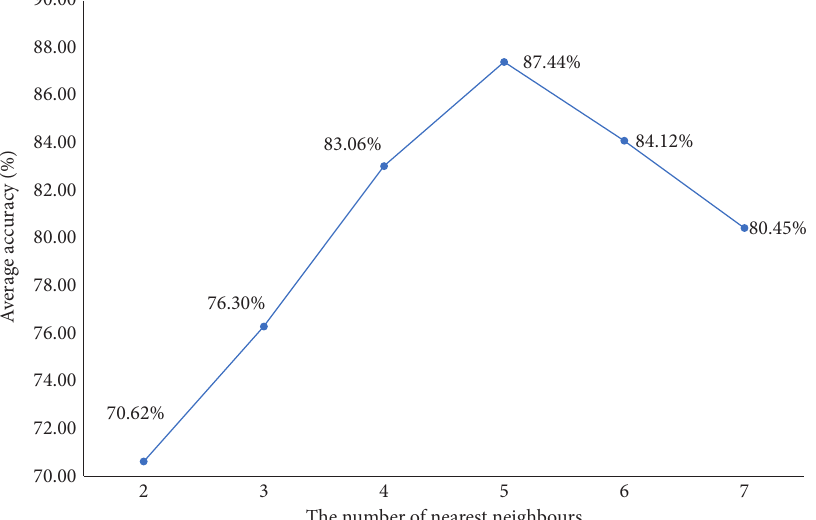
Figure 7: Variations of average accuracy with the increased number of nearest neighbors for M-GL.